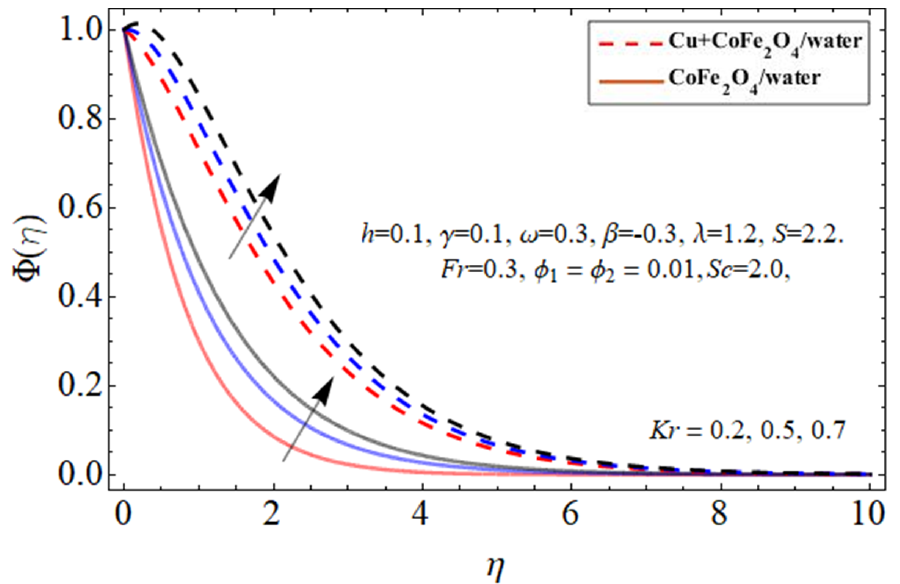
( ) ηΦ profile versus the chemical reaction Kr .